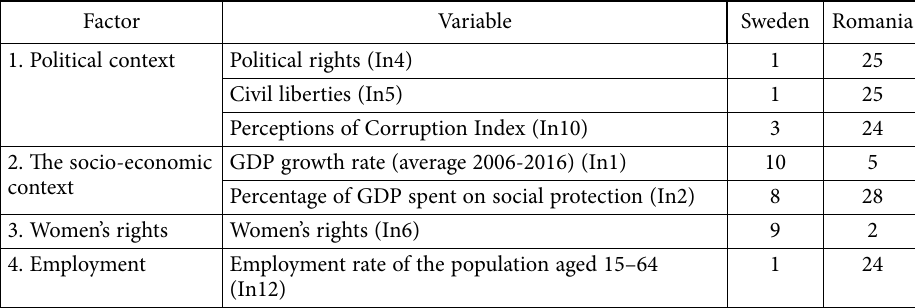
Table 7. SPSS ® , Sweden versus Romania Factor Variable Sweden